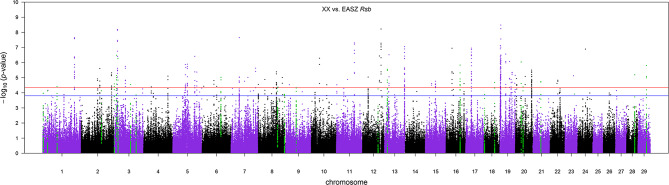
The Manhattan plot of p-values for Rsb analysis between the admixed cattle with a minimum number of three crossovers per Morgan and the East African Shorthorn Zebu population. The red and blue horizontal lines are false discovery rate thresholds at 0.05 [−log10(p-value) = 4.35] and 0.10 [−log10(p-value) = 3.80], respectively. Green points are the SNPs within the candidate regions identified as being under selection in the crossbred population.